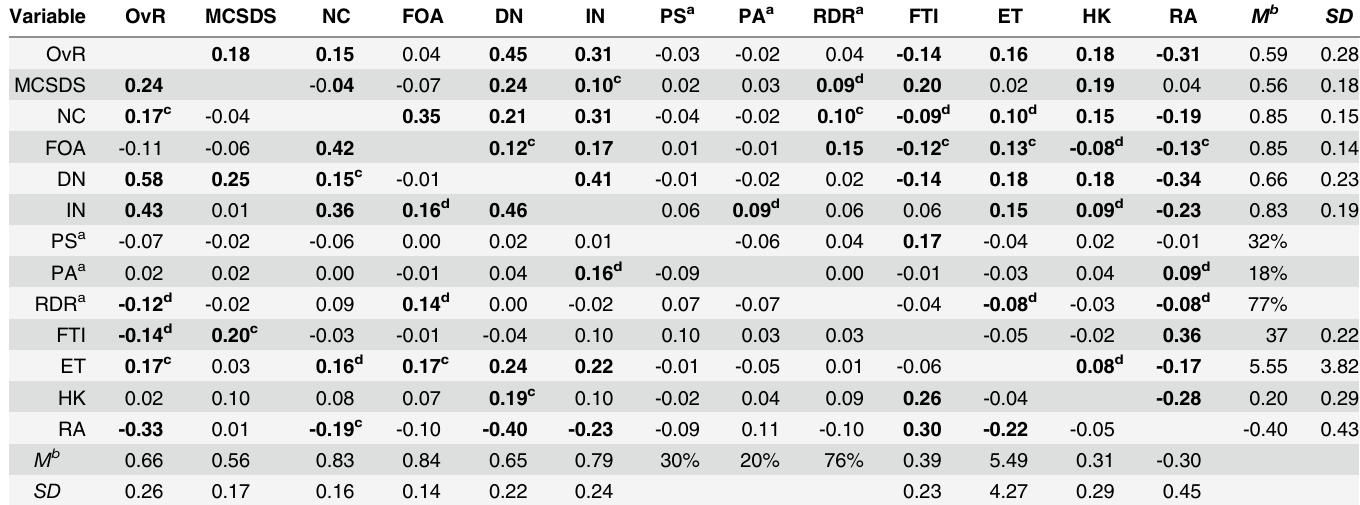
Table 2. Descriptive statistics and Pearson correlations for stool-related over-reporting (below diagonal) and food-related over-reporting (above diagonal) with predictor